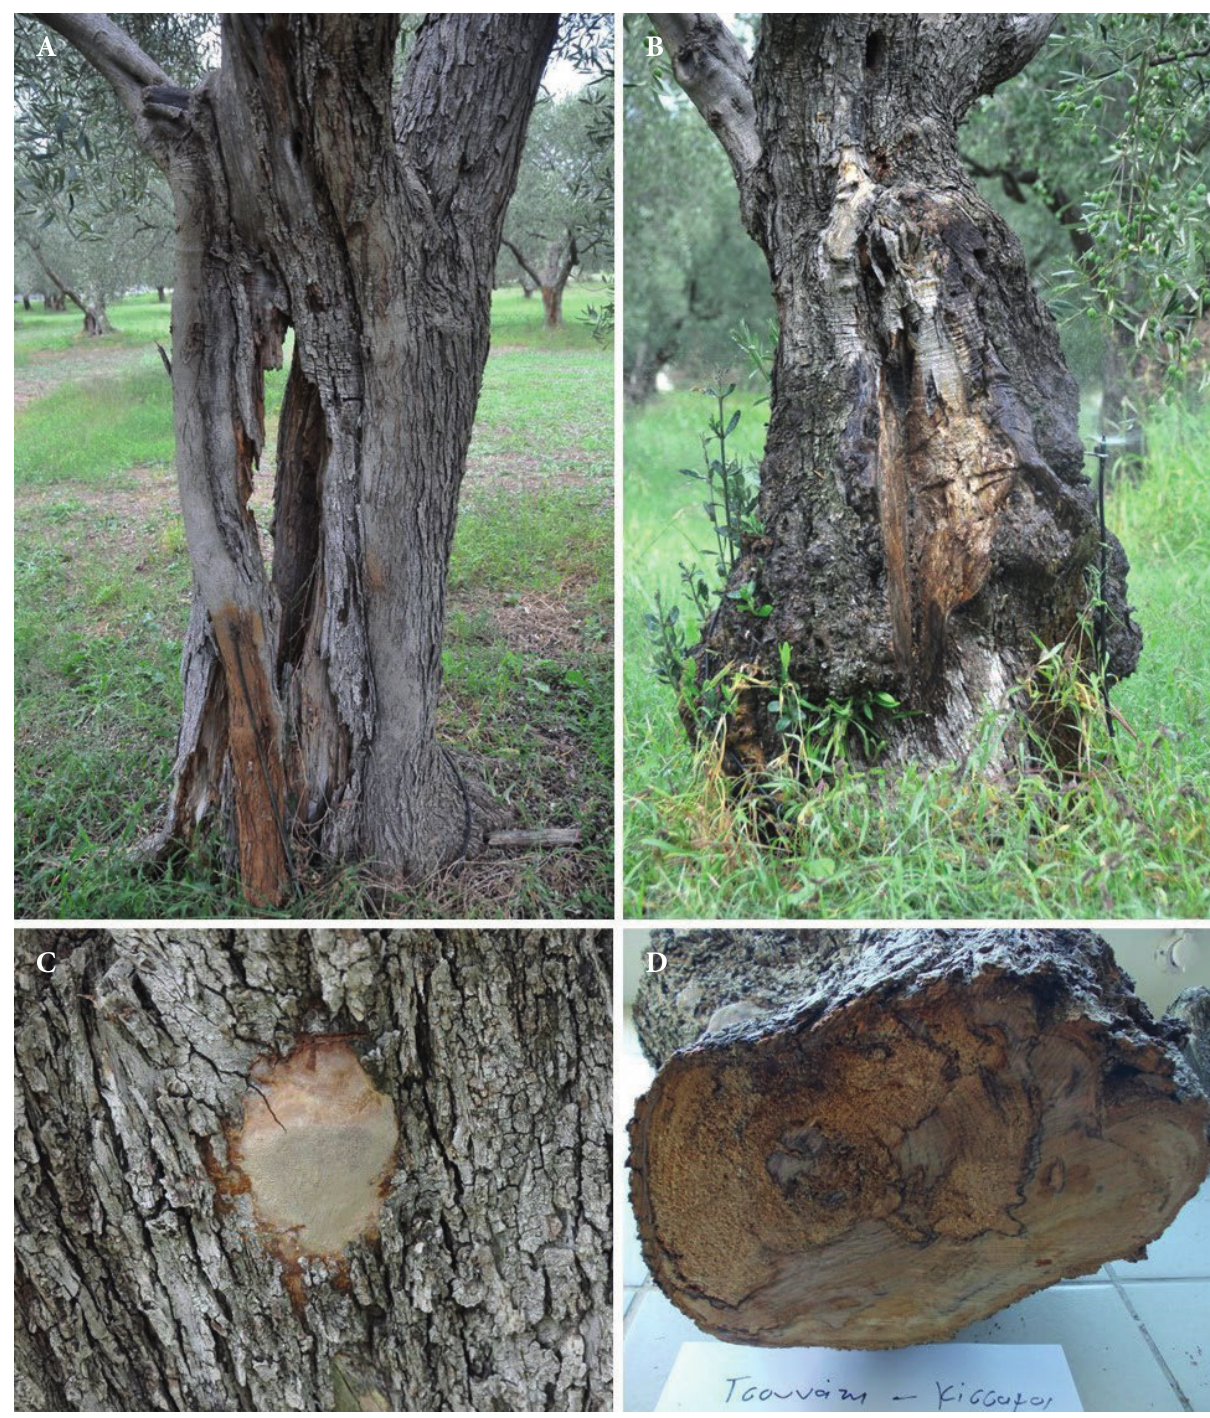
Figure 2. Wood decay (Esca) symptoms in olive trees in Thrace, Northeastern Greece, infected by Fomitiporia mediterranea . Canker in the trunk ( A ); white rot appeared after removing a trunk sector due to incorrectly adjusted irrigation sprinklers which created conducive condi- tions for fungal infection ( B ); carpophore of F. mediterranea formed on the trunk surface ( C ); trunk cross section revealing light-coloured wood rot surrounded by a brown necrotic zone ( D